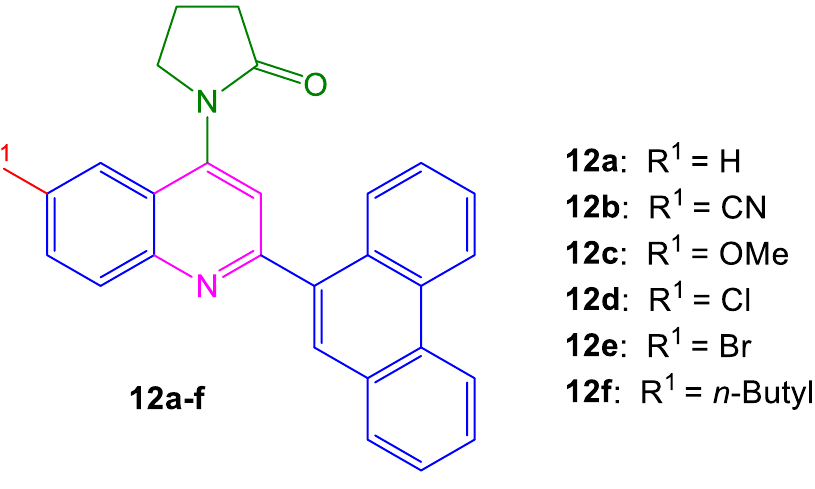
Figure 8. Structure of compounds ( 12a – f ).